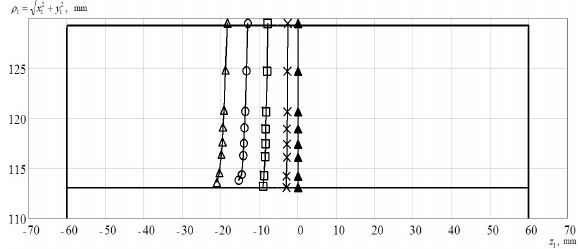
Figure 7. Active lines of action in meshing γ =0 ( ▲ ); 1´ ( × ); 3´ ( □ );5´ ( ○ ) and 7´ ( ∆ ) (variant 1) Figure 8 represents active lines of action in meshing with γ =0´; 1´; 3´; 5´ and 7´ for variant 2